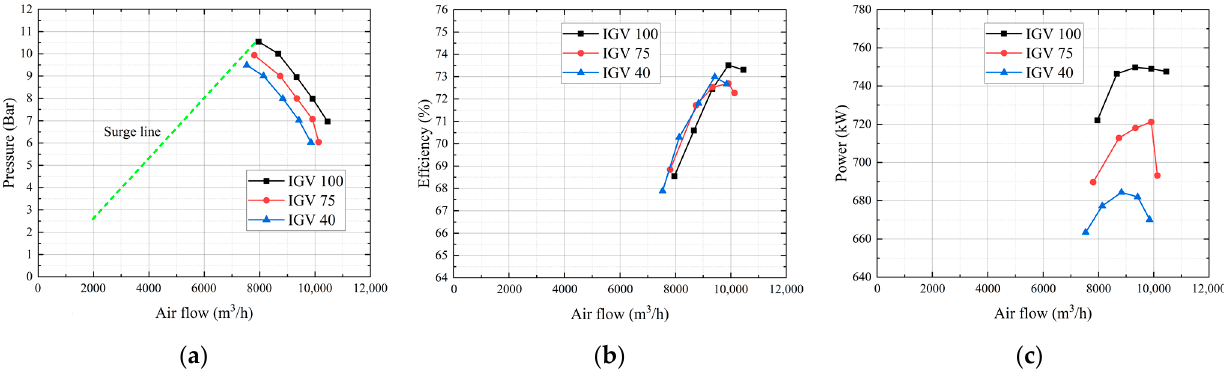
Figure 9. Performance curves of the TACCS with the variable speed drive (VSD). ( a ) Pressure curves; ( b ) isothermal efficiency curves; ( c ) power curves.